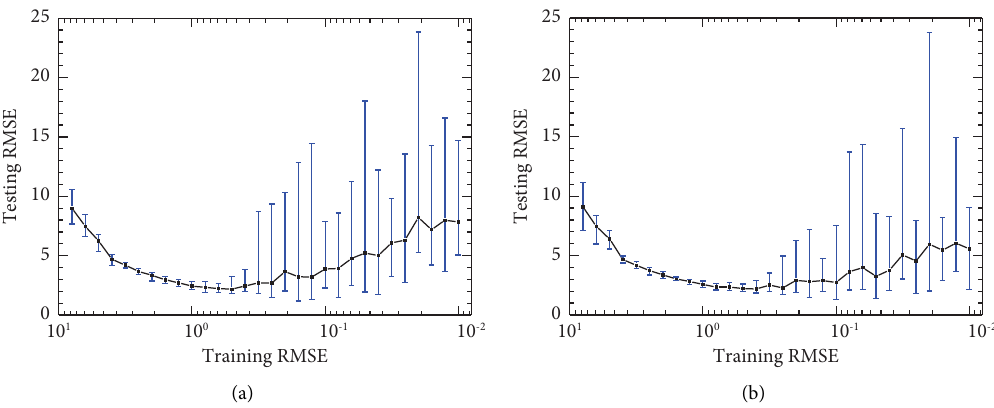
Figure 7: Testing RMSE (with error bar) vs. training RMSE by Elman neural network models. (a) Hidden node number � 10. (b) Hidden node number � 20.